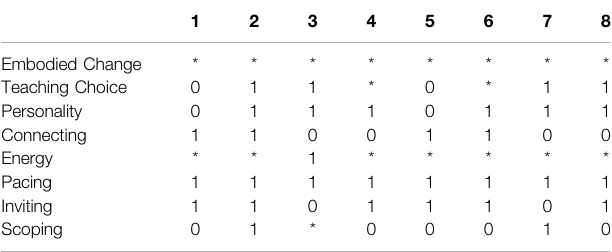
TABLE 2 | Presence of expressed themes per